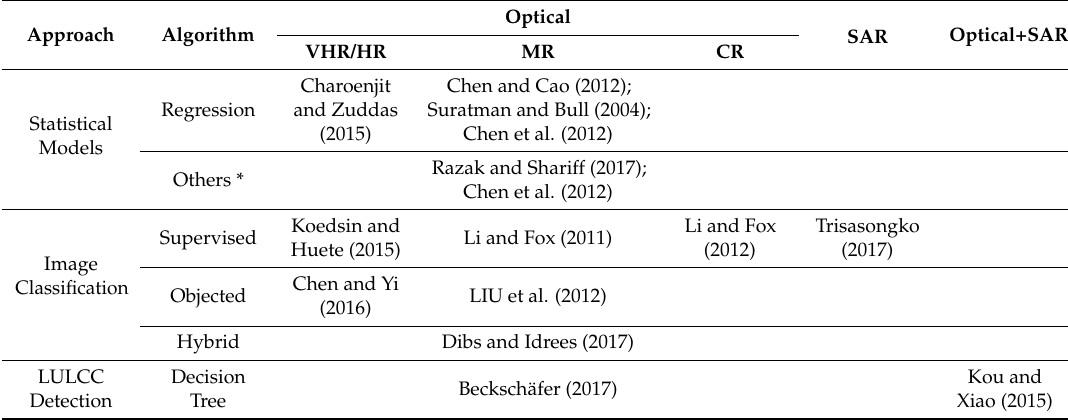
Table 1. Selected peer-reviewed references related to remote sensing estimates the stand age of rubber